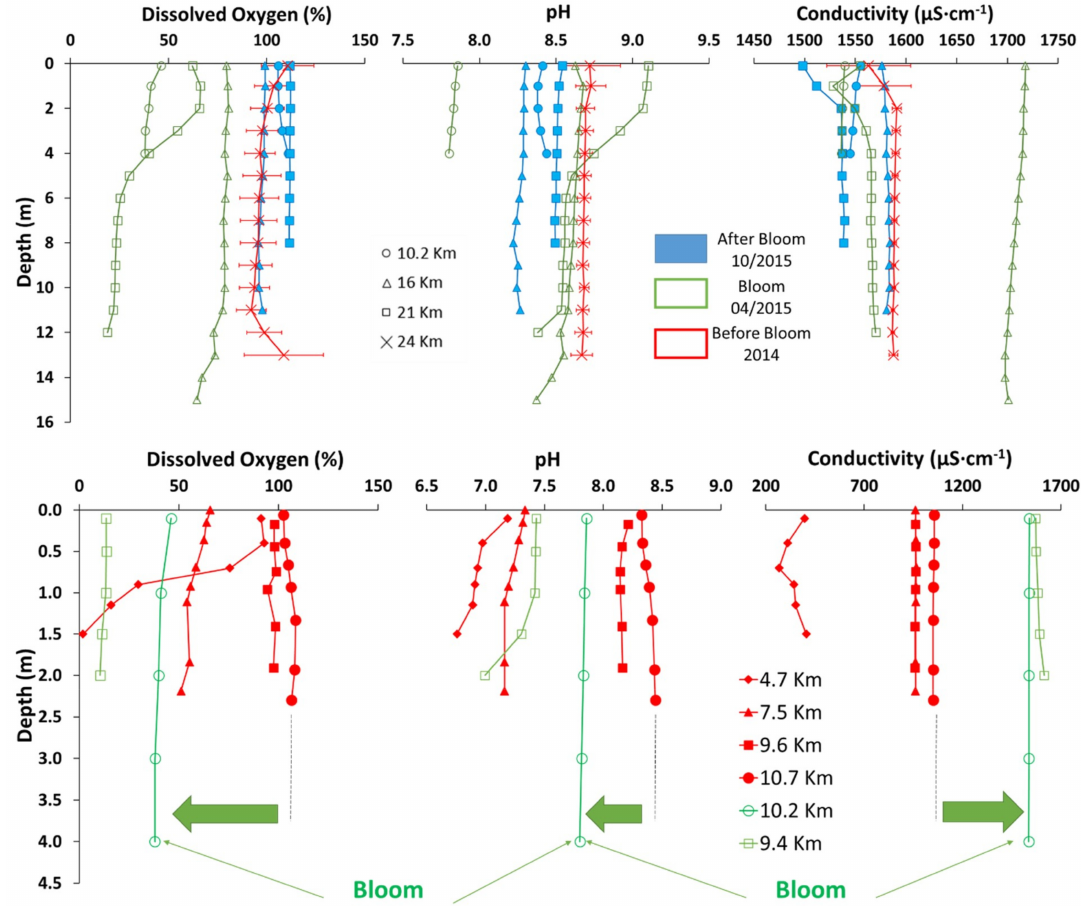
Figure 2. Oxygen, pH and conductivity profiles of the water column along open lake through the small basin of Lake Titicaca (upper panel) and along the Cohana Bay (lower panel) during the bloom (empty green symbols), few months after the bloom (full blue symbols), and a year before (empty red symbols). Distances are from the Katari River inlet to the lake. Error bars for 2015 data represent 20 to 40 measurements, while for 2014 data represent between 200 to 400 data collected through the 24 h period. Thick arrows highlight the shift in values between the bloom event and normal